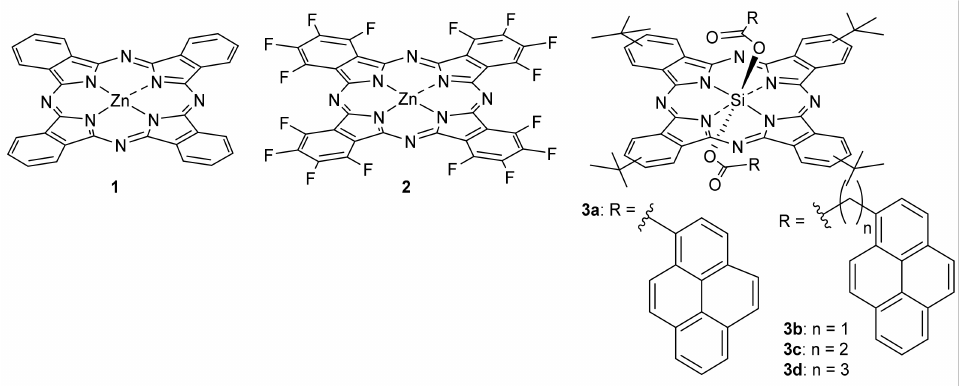
Figure 3. Pcs used in photovoltaic ternary systems.